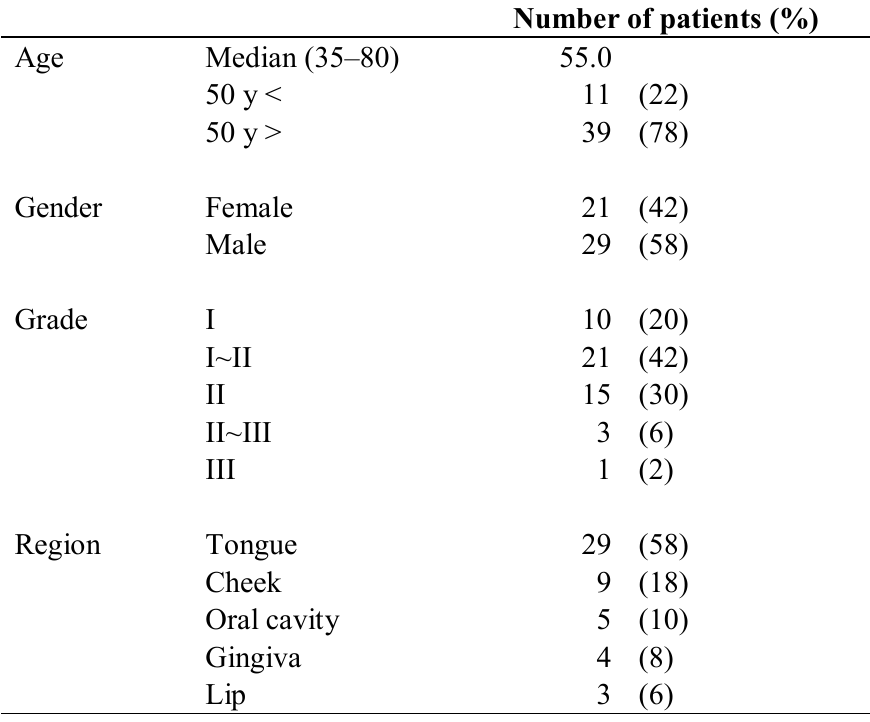
Table 1. Clinicopathological characteristics of the patients with